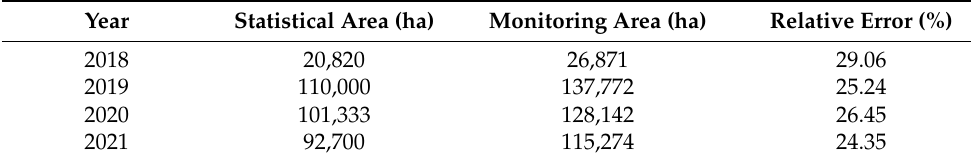
Table 6. Accuracy evaluation of monitoring area over the years.